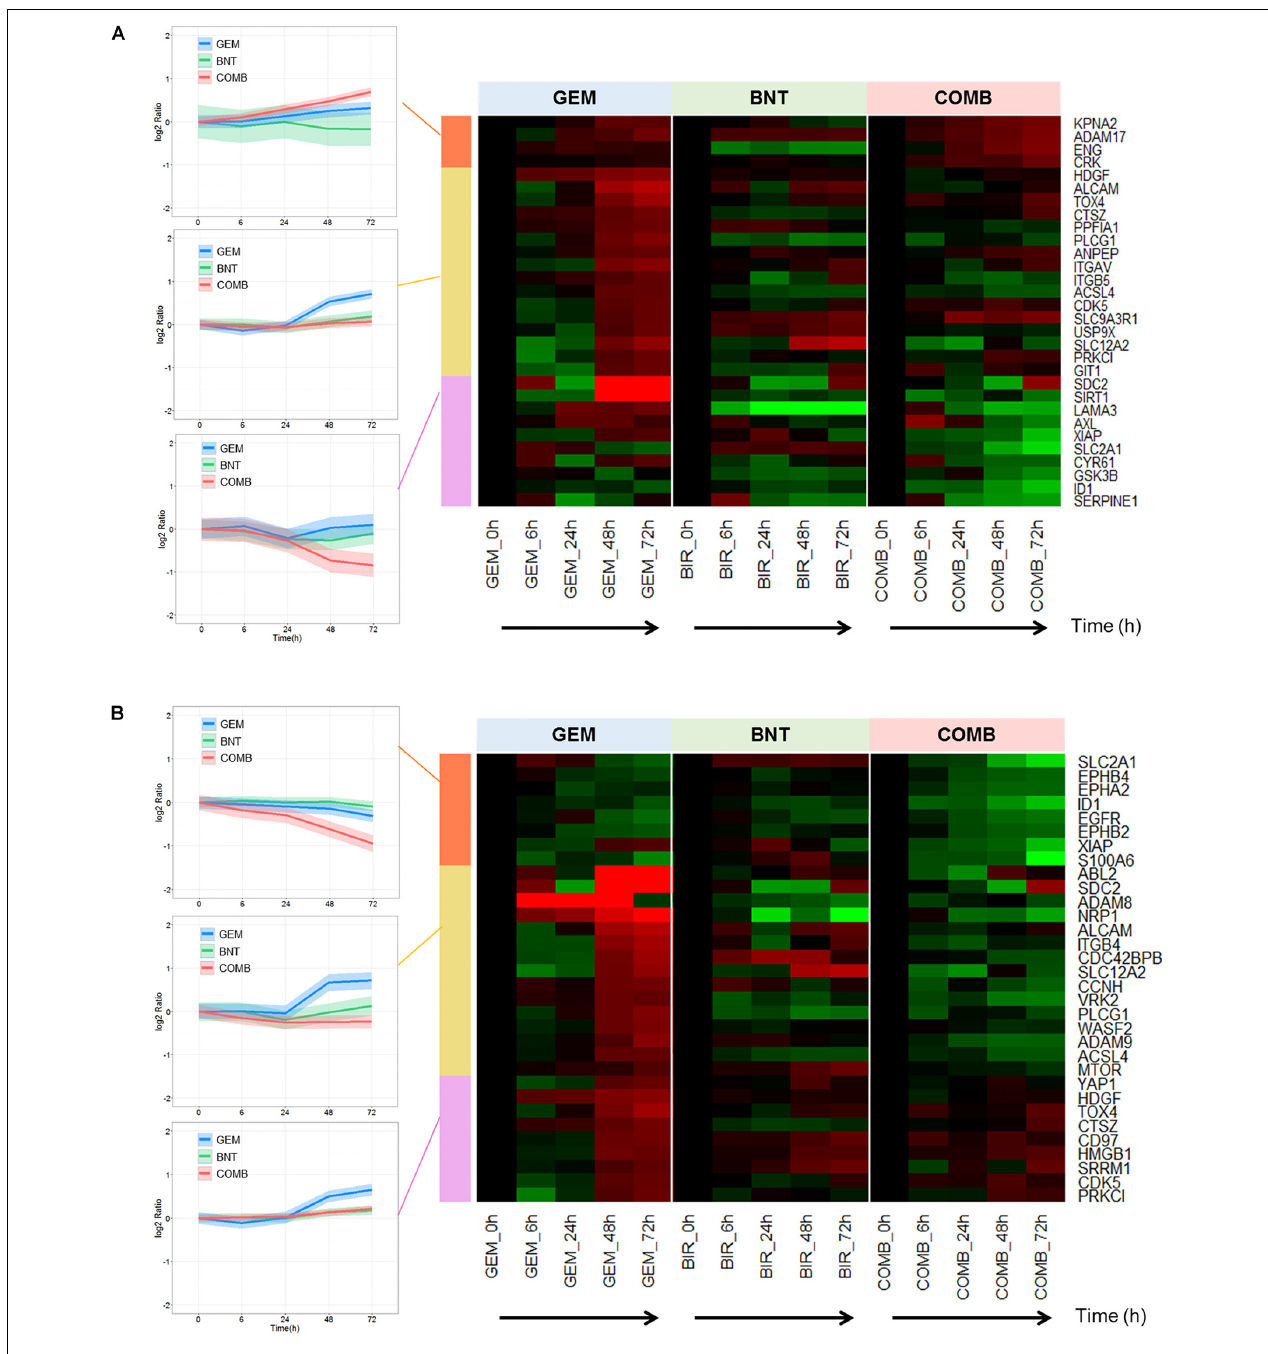
FIGURE 6 | Proteins involved in migration and invasion affected by gemcitabine/birinapant treatment. Significantly altered proteins related to (A) induction of migration and (B) increasing invasion that were identified and quantified by proteomic analysis and summarized in the heat map plot. Clustering of protein and colors are defined in the Figure 3 legend. The proteins relevant to each gene name in the heat map are summarized in Supplementary Table